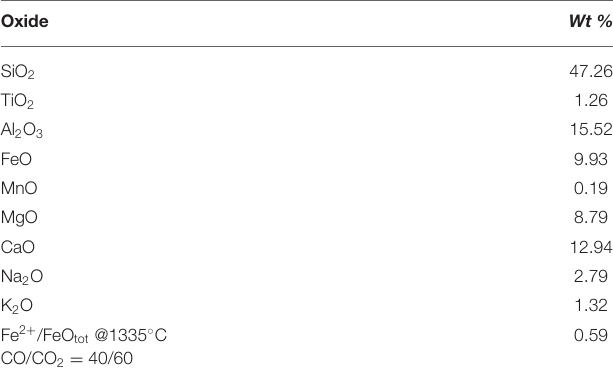
TABLE 1 | Composition of the sample in this study as wt % oxides measured via elecrton probe microanalysis (EPMA) after the experiments; normalized to 100% (analytical precision is better than 2.5%